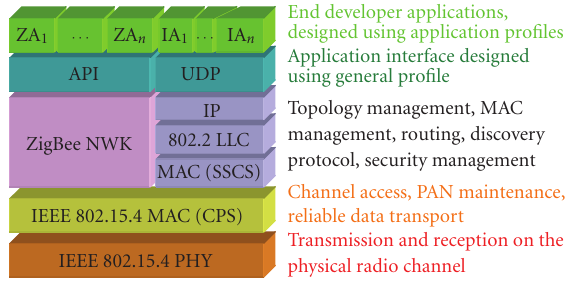
Figure 6: Illustration of ZigBee